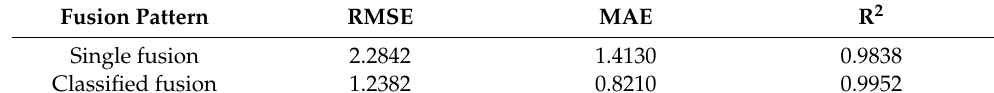
Figure 13. Predicting results of IPSO – LSTM in different fusion patterns.